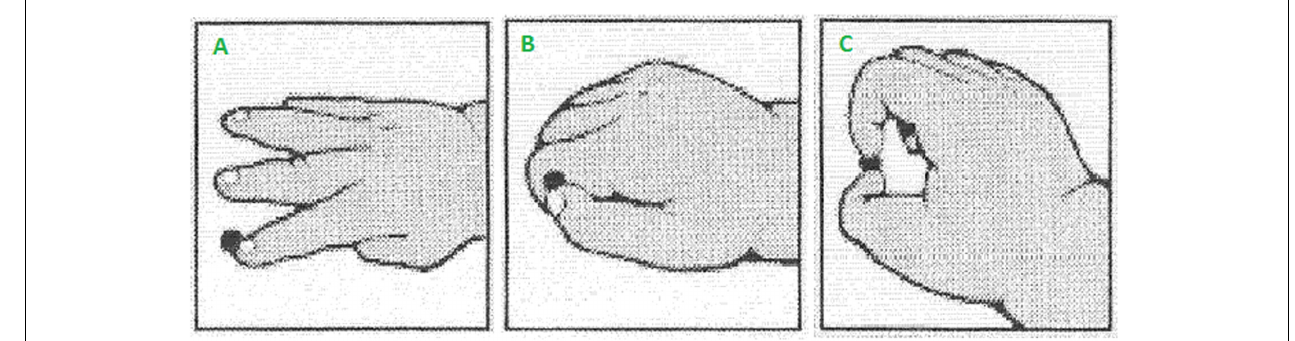
FIGURE 2 | Illustrations depicting classification of grasping actions into whole hand (A) , transitional (B) , or pincer (C) grasps during the grasp test. Only (C) was considered a true pincer grasp as this action requires opposition of the thumb and forefinger. Image modified with permission from Erhardt (1994).